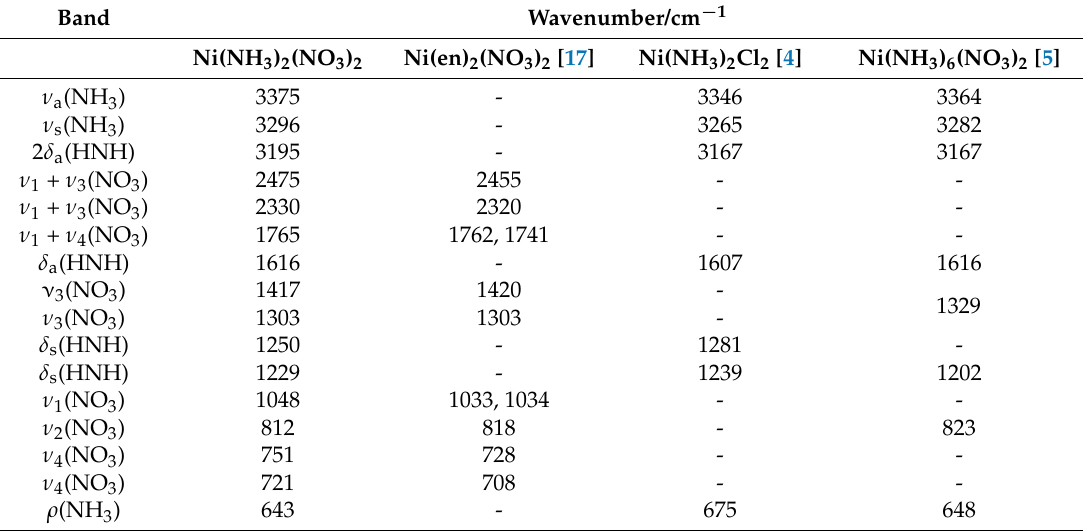
Table 4. Assignment of the infrared bands in Ni(NH 3 ) 2 (NO 3 ) 2 in comparison to the documented